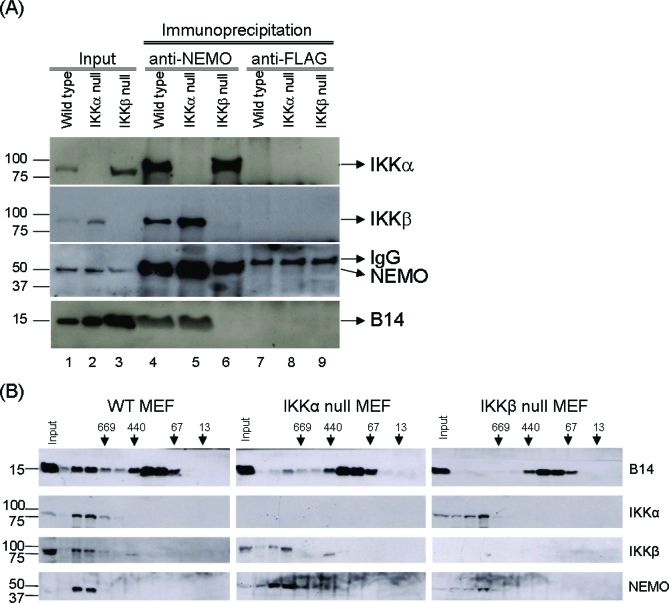
B14 Binds to the IKK Complex via IKKβ(A) Wild type, IKKα null, and IKKβ null MEF cells were infected with vB14-HA and cell extracts were immunoprecipitated using anti-NEMO mAb. The immunocomplex was resolved by SDS-PAGE (12% gel) and analysed by immunoblotting using the indicated Abs.(B) Cell extracts from vB14-HA-infected MEFs were prepared and analysed by SEC on a Superose 6 column. Proteins from each fraction were precipitated using trichloroacetic acid and 15% of the sample was separated in a 12% SDS-PAGE and analysed by immunoblotting using the indicated Abs.